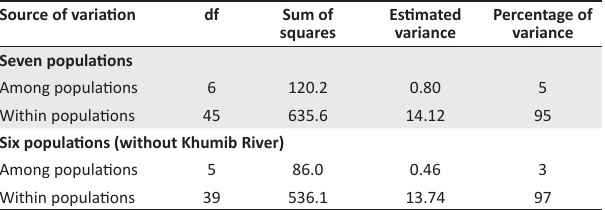
< 0.001). random ≥ data